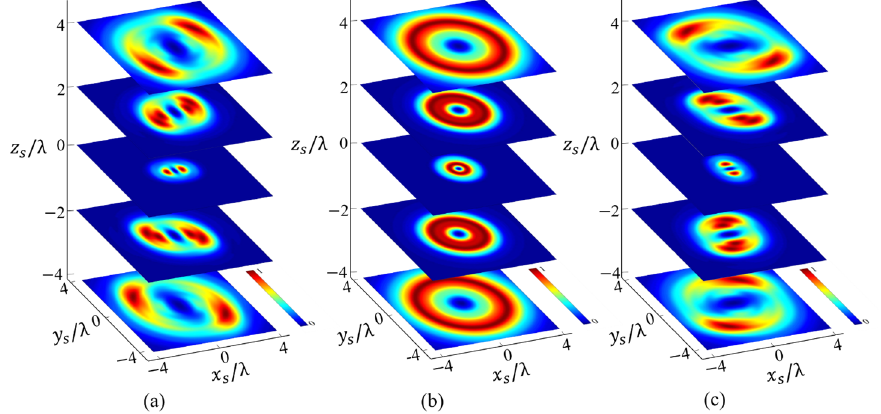
Figure 5. The longitudinal energy flow 𝑝 (cid:3053) along the propagation direction: ( a ) 𝜎 (cid:3030) = 0.5 ; ( b ) 𝜎 (cid:3030) = 1 ; ( c ) 𝜎 (cid:3030) = 2 . In all the plots 𝑙 = 2 . ( c ) σ c = 2. In all the plots l =